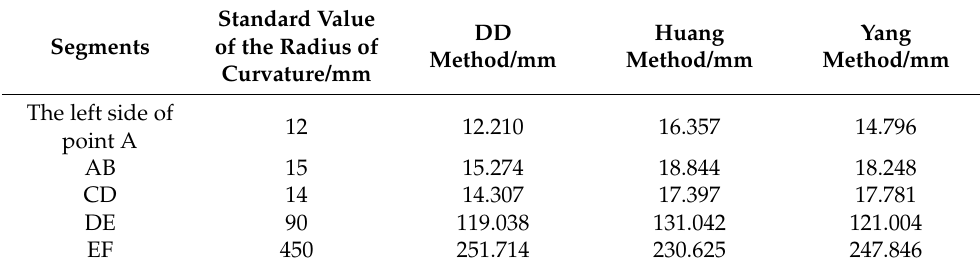
Table 4. The results of calculating LM A -type profile’s radius of curvature.